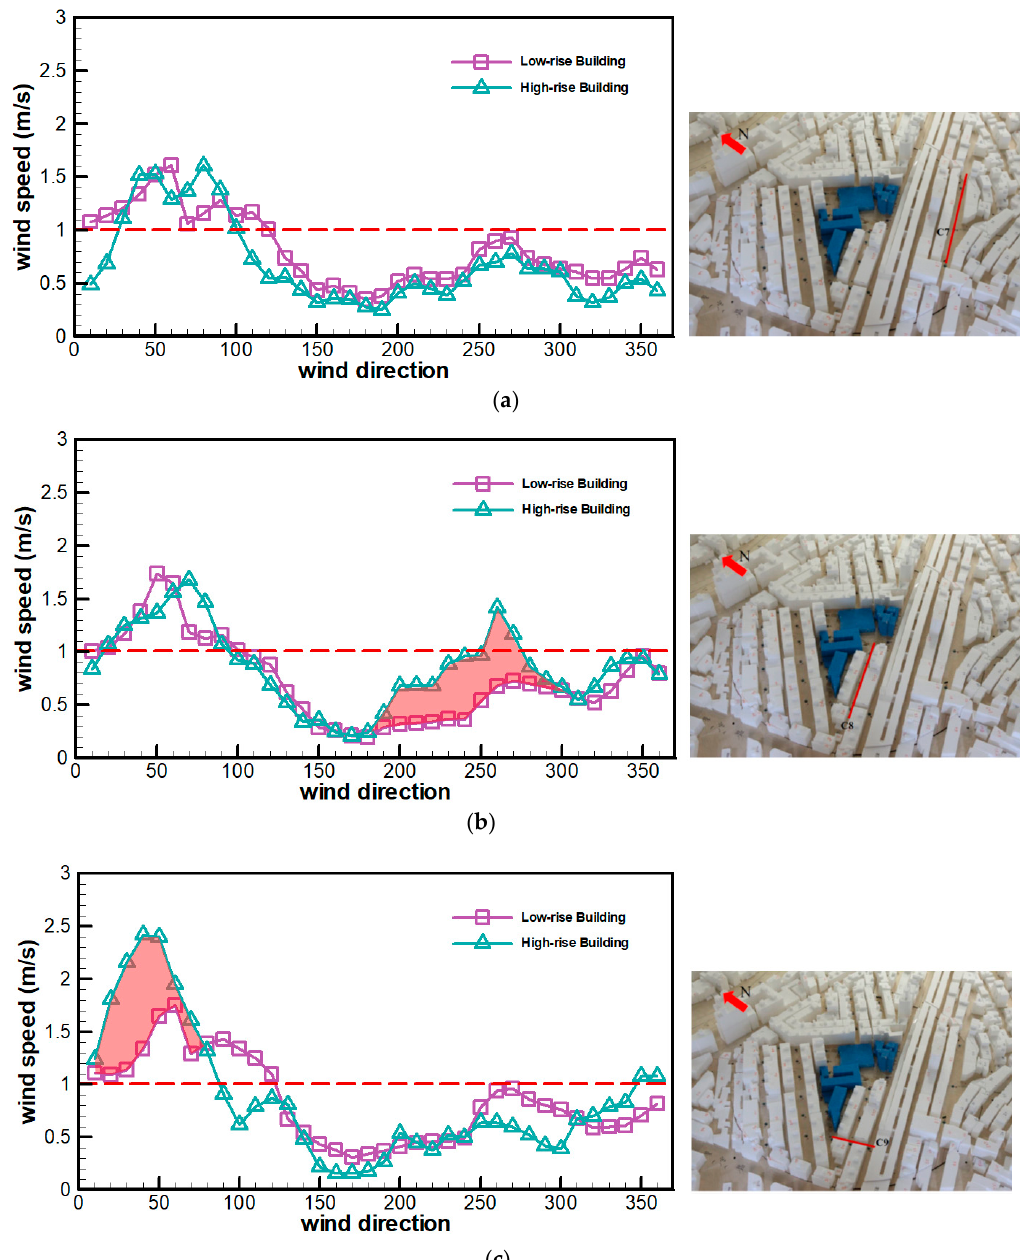
Figure 7. Characteristics of pedestrian wind environments in C7–C9 before and after urban renewal.